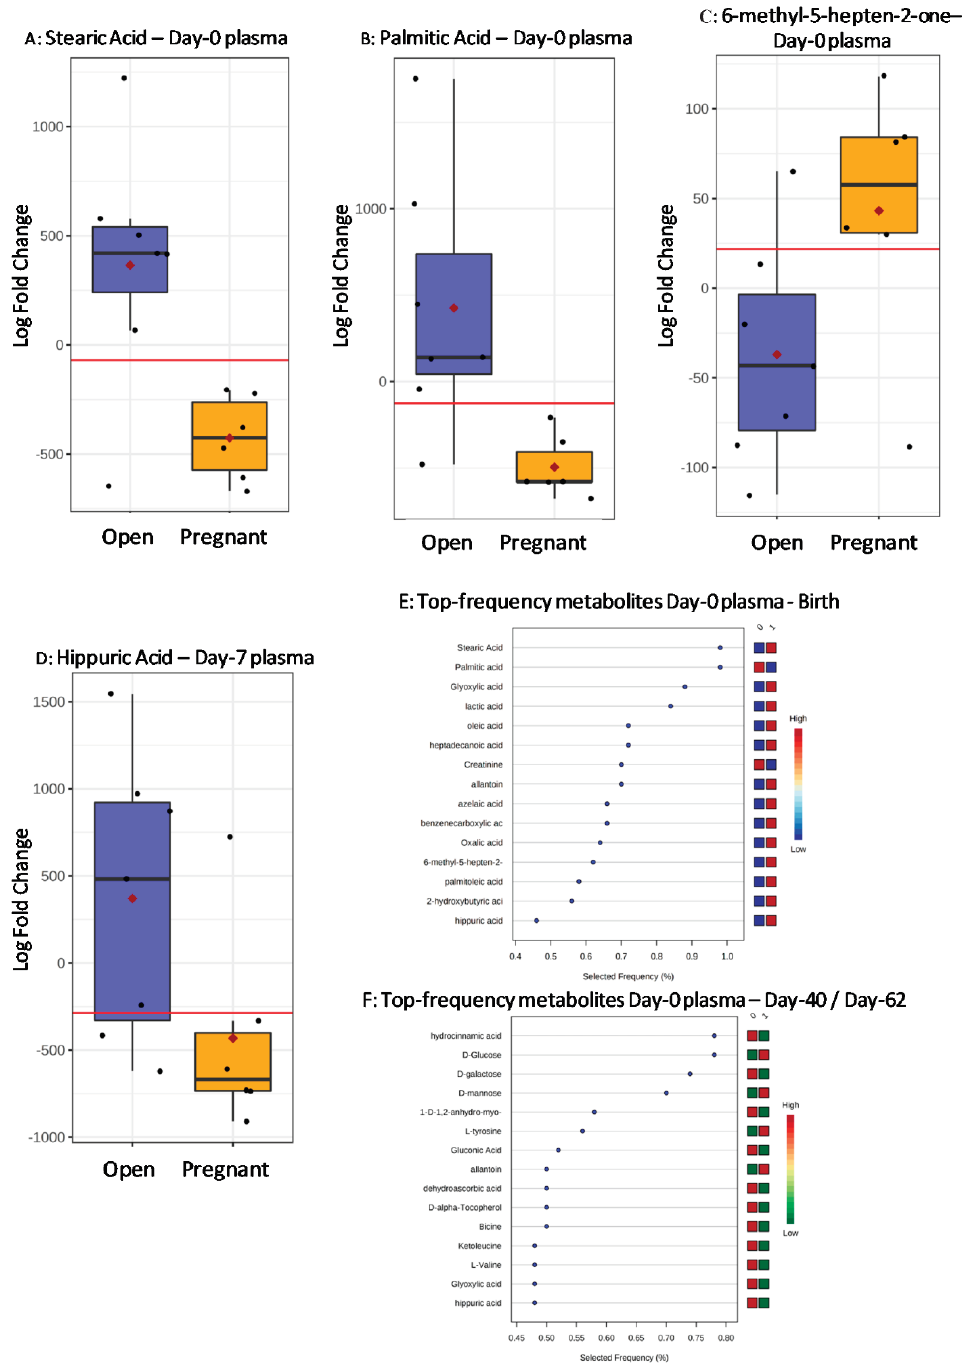
Figure 3. Boxplots of the biomarker metabolites measured in Day-0 plasma of Asturiana de los Valles recipients trans- ferred with vitrified/warmed embryos (discovery study) as diagnosed at birth (i.e., Stearic Acid, ROC-AUC = 0.881 (0.571–1.000) ( A ), Palmitic Acid, ROC-AUC = 0.976 (0.786–1.000) ( B ), and 6-methyl-5-hepten-2-one, ROC-AUC = 0.833 (0.500–1.000) ( C )), and in Day-7 plasma (Hippuric Acid, ROC-AUC = 0.857 (0.571–1.000) ( D )), from open (blue boxes) and pregnant (yellow boxes). Black dots represent the concentrations of all samples of each metabolite scaled as Log Fold Change values. The notch indicates the 95% confidence interval around the median. The mean concentration of each group is shown by a red diamond. The optimal cut-off is indicated as a horizontal red line (i.e., the closest to the left-hand corner in the corresponding ROC-AUC). Frequency rankings by a Support Vector Machine (SVM) algorithm for top biomarkers, including those of the above boxplots, are shown on Day-0 plasma at birth ( E ), and on gestational days 40 and 62 (same biomarkers) ( F ) (1: Pregnant or birth to term recipients. 0: open